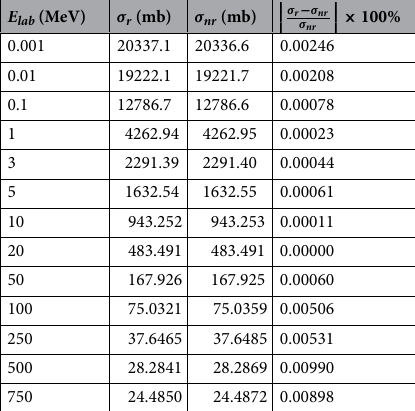
Table 3. The total cross section of np elastic scattering as a function of the incident projectile energy E lab , calculated for relativistic ( σ r ) and nonrelativistic ( σ nr ) CD-Bonn